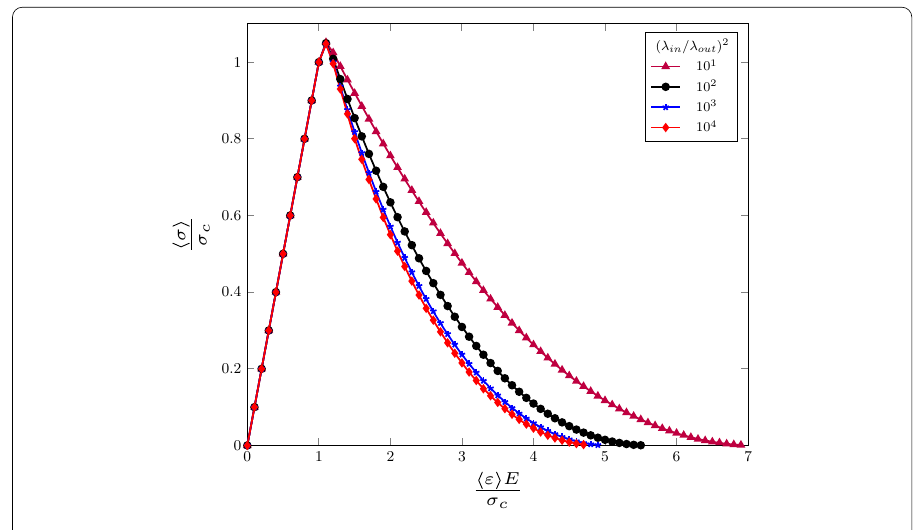
Fig. 4 Effect of the interface condition at the edges of the interphase on the global stress–strain response